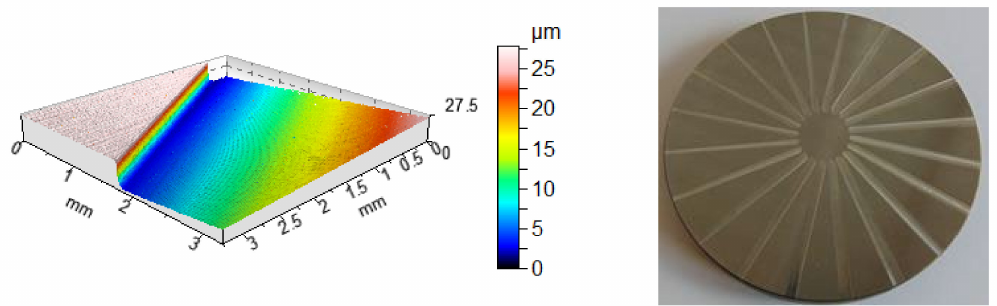
Figure 2. Isometric view of the bottom of the groove of a sharp edge on one side and a convergent bottom ( left ) and sample view with straight radial grooves of type 1 ( right